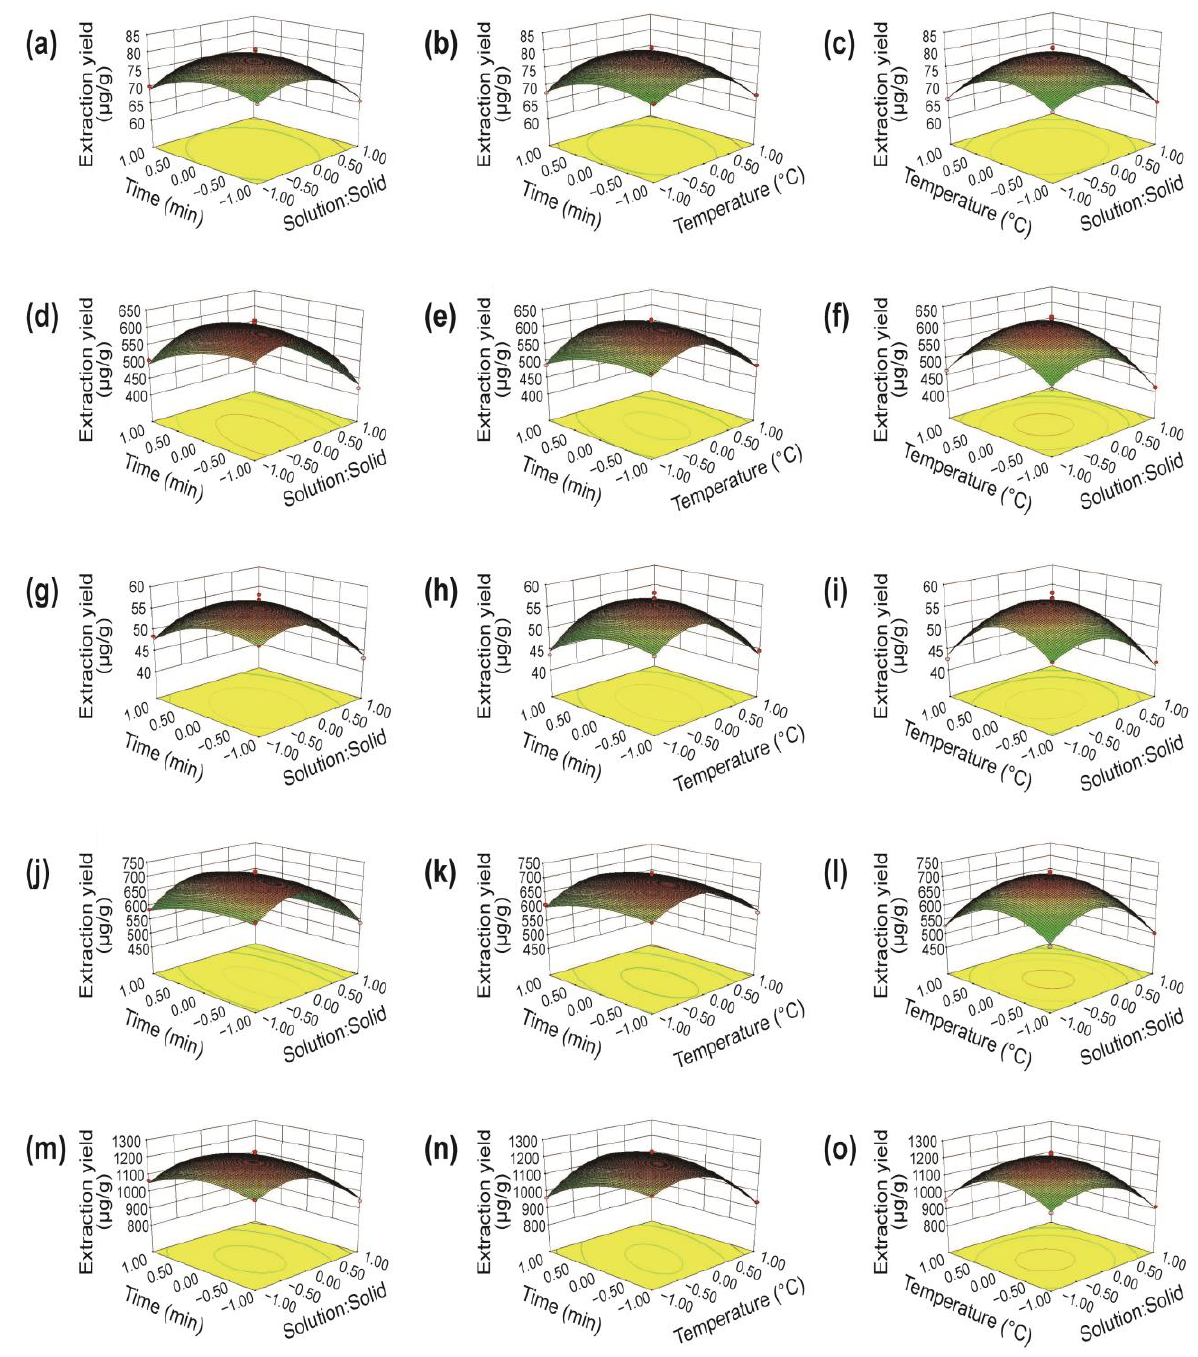
Figure 2. Response surface plots of the models for C1 ( a – c ), C2 ( d – f ), C3 ( g – i ), C4 ( j – l ), and C5 ( m – o ) of maca